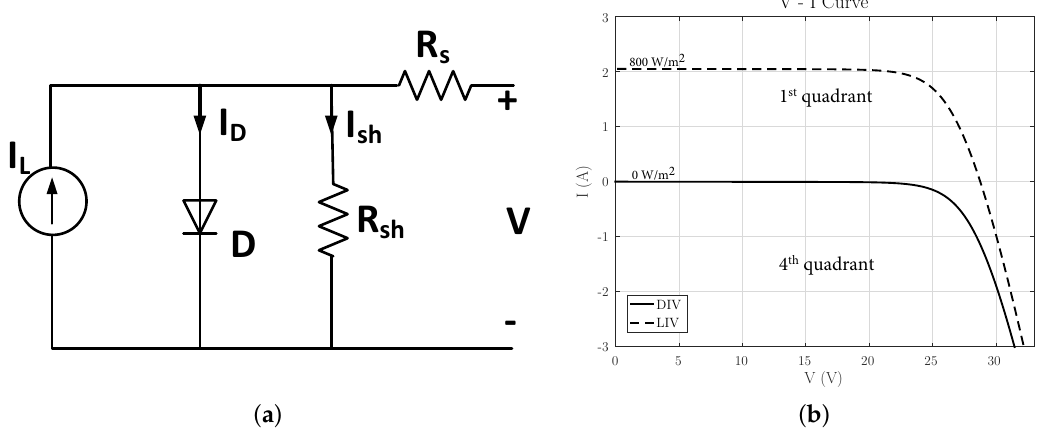
Figure 1. Classic electric model of photovoltaic (PV) panel ( a ) and light I–V (LIV) and dark I–V (DIV) curves of a standard 36 PV cell module according to the work in [14] ( b